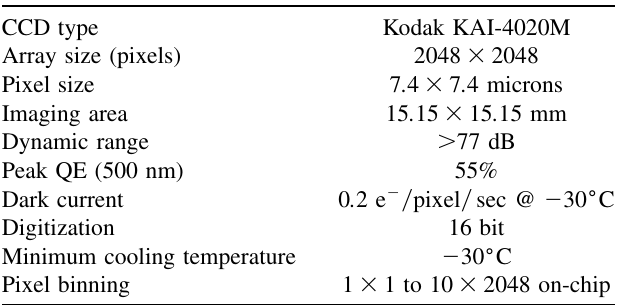
TABLE III. Alta E4000—High performance cooled CCD camera system specifications.